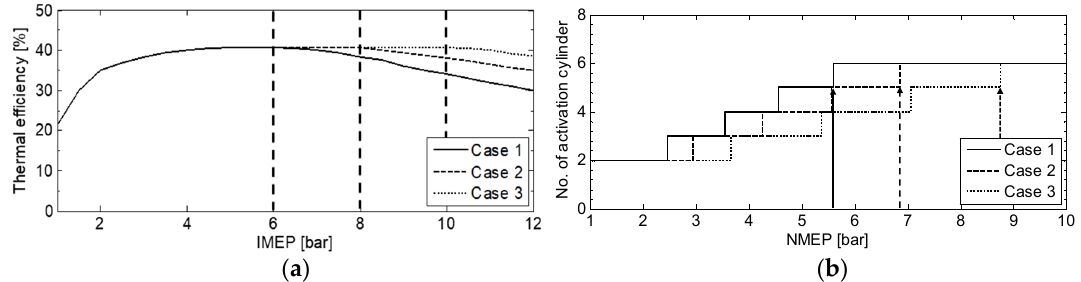
Figure 6. Comparison of data between cases; ( a ) thermal efficiency; ( b ) number of activated cylinders in cases 1, 2, and 3 and NMEP. Table 7. Fuel economy improvement in FTP-75 of each case.